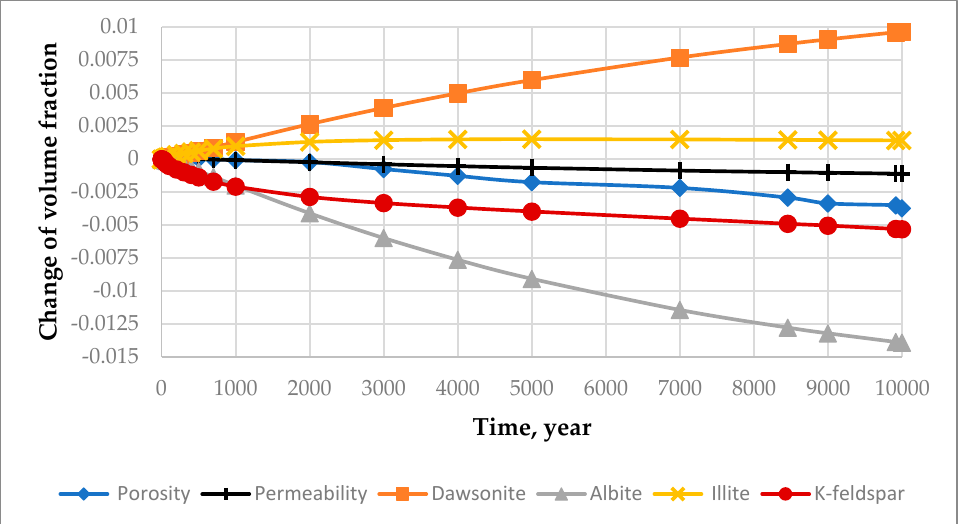
Figure A10. Change in volume fraction of different minerals in the homogenous case along with porosity and permeability alteration near the injection well in reservoir’s uppermost layer throughout the 10,000 years of simulation. Change in permeability is in Darcy.